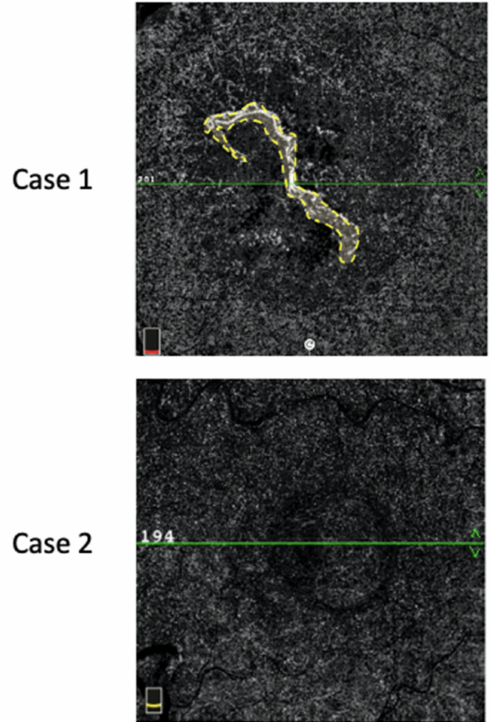
Figure 2. MNV-flow area (mm 2 ) defined by the yellow dotted line (Case 1). In Case 2, no flow could be detected inside the PED; thus, the flow area was considered